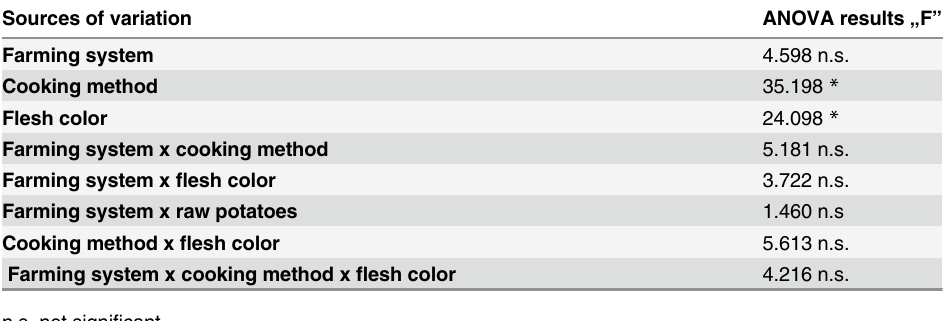
Table 4. Sources of variation and ANOVA results „ F ” for effect of different cooking methods and flesh color on ascorbic acid contents (see Table